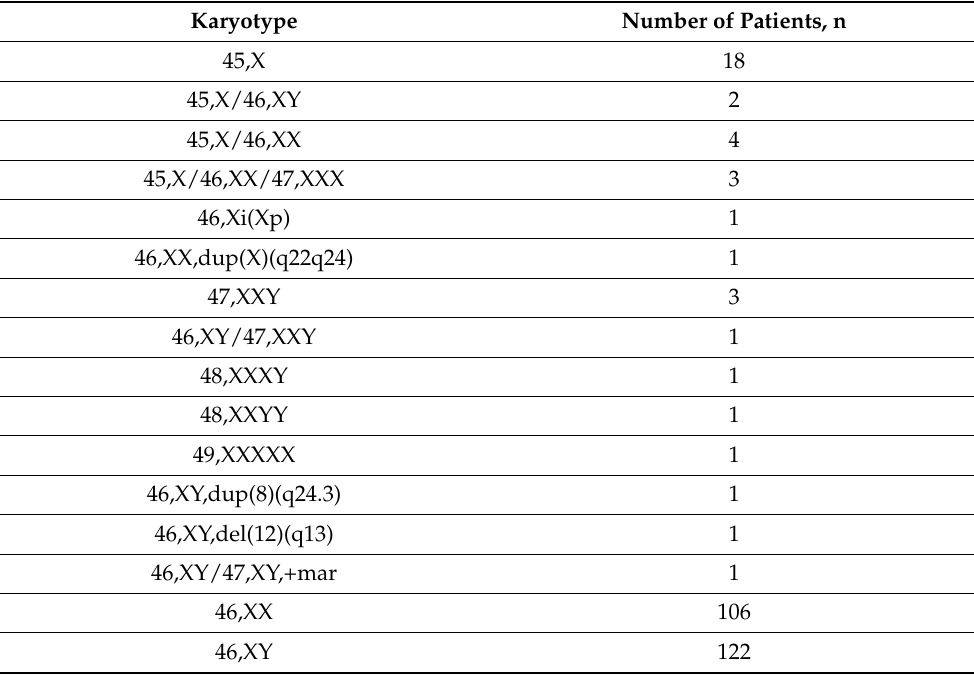
Table 1. Karyotypes observed in DSD